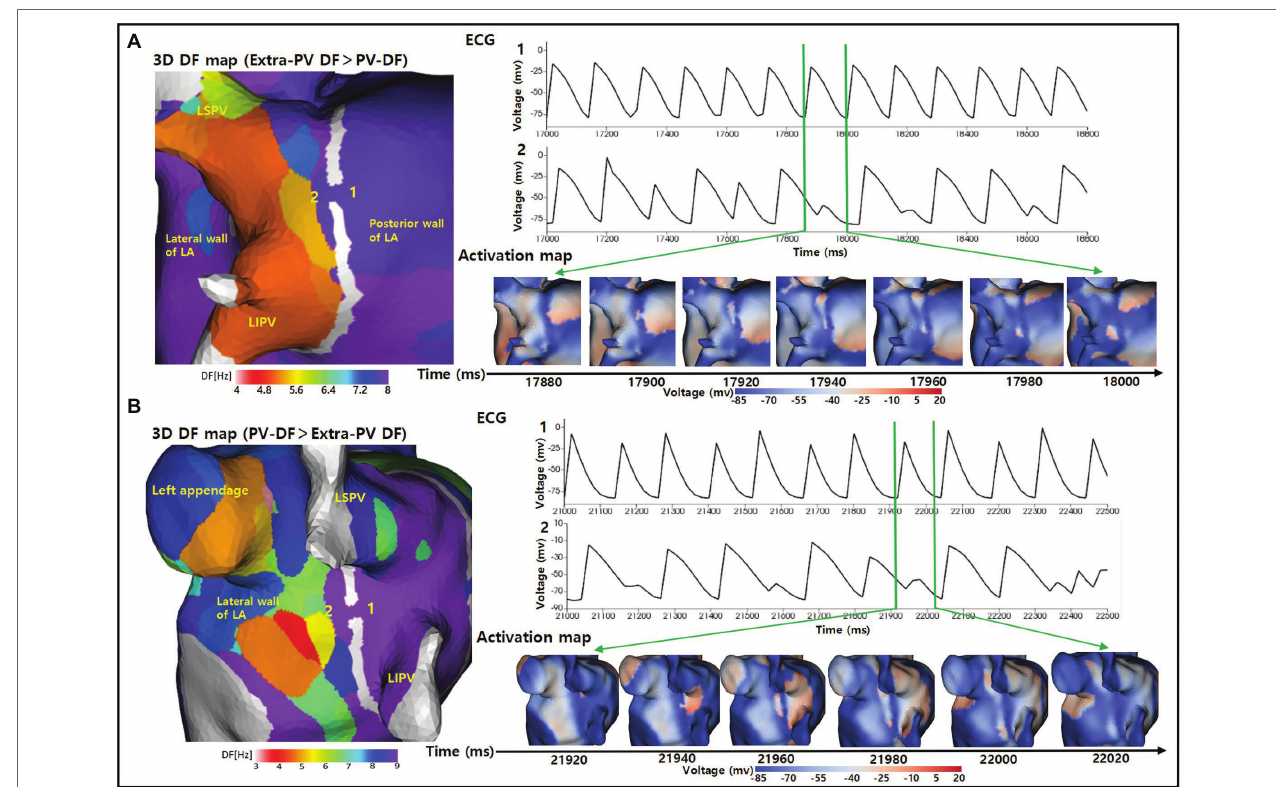
FIGURE 4 | Wave-break at the wavelet exit of the gaps by a source-sink mismatch. (A) The 3D DF map indicates that the extra-PV DFs was greater than the PV- DFs. The activation map and ECG indicate that a regular wavelet turned into a wave-break when moving from the posterior wall of the LA to inside the PV through the gap. (B) The 3D DF map indicates that the inside PV-DF was greater than the extra-PV DF. The activation map and ECG indicate that a regular wavelet turned into a wave-break when moving from inside the PV to the lateral wall of the LA through the gap. DF indicates dominant frequency; PV, pulmonary vein; LA, left atrium; LSPV, left superior pulmonary vein; LIPV, left inferior pulmonary vein; ECG,